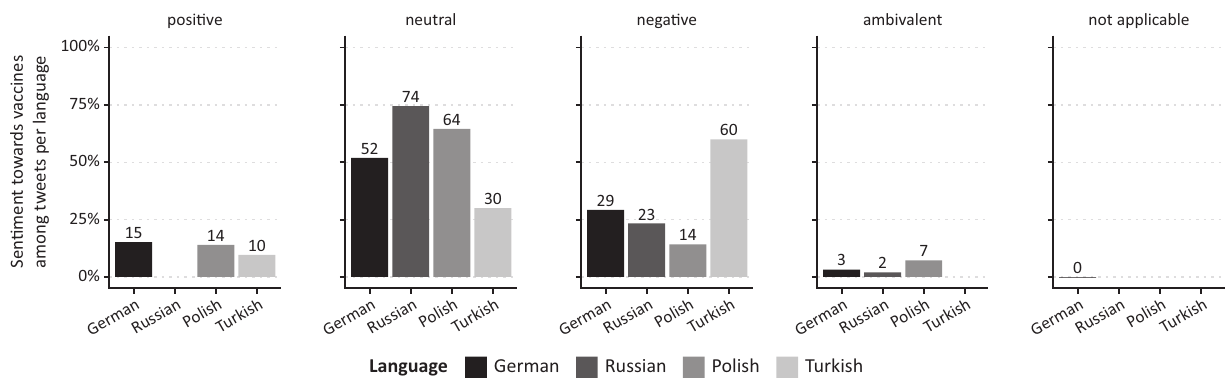
Figure 6. Sentiments towards the AstraZeneca vaccine. Notes: The base for each language is the number of tweets that mention the AstraZeneca vaccine; n = 920, German ( n = 839), Russian ( n = 47), Polish ( n = 14), and Turkish ( n = 20); Cramer’s V = 0.09; p <